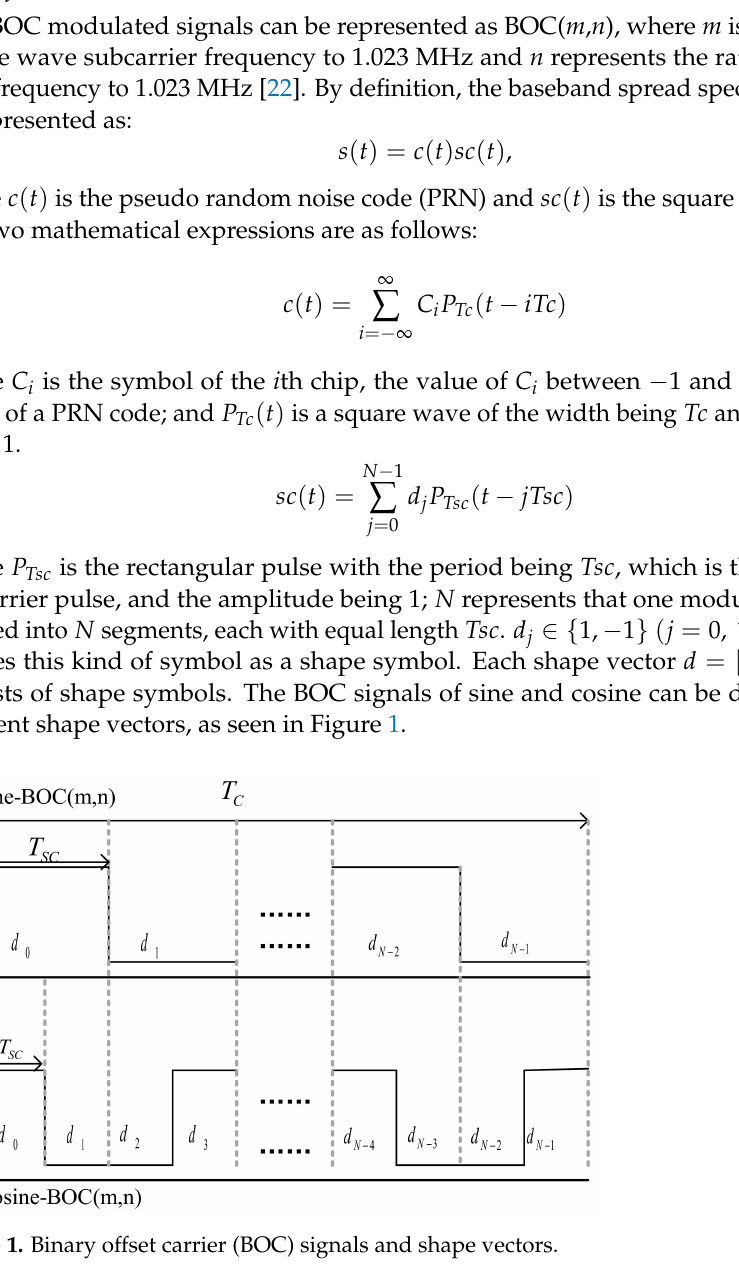
. For ex- N × 1 , Tsc = Tc /2. Similarly, for Cosine- 2 , 4